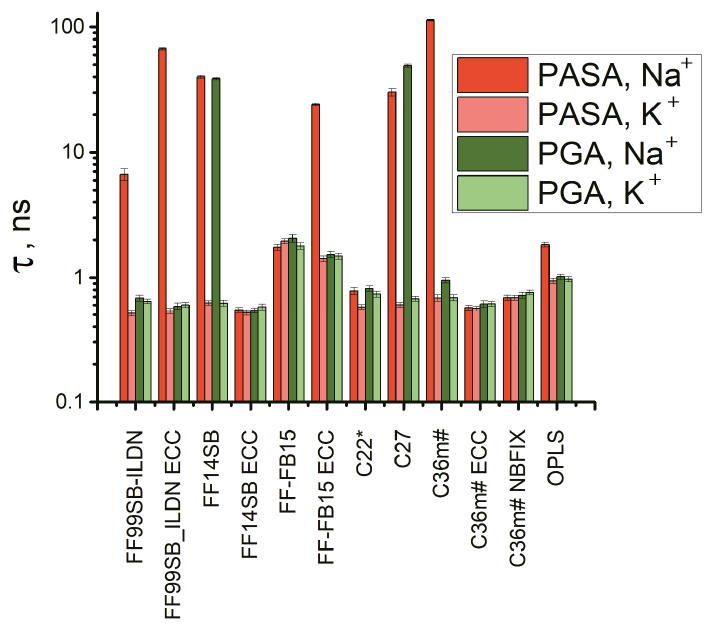
Figure 12. Relaxation times of the end-to-end distance in PASA and PGA molecules with K + and Na + counterions. Computed using Equation (2).